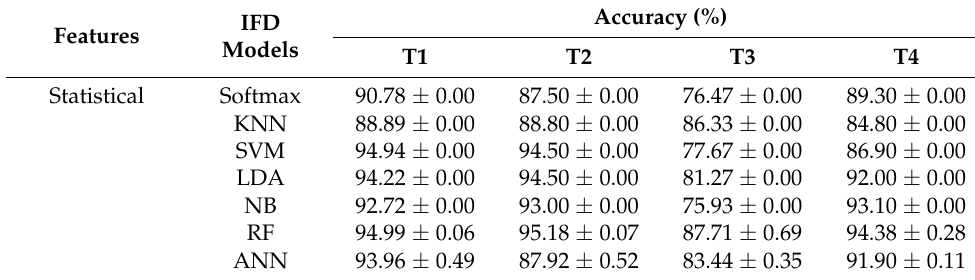
Table A2. The diagnostic accuracies on bearing